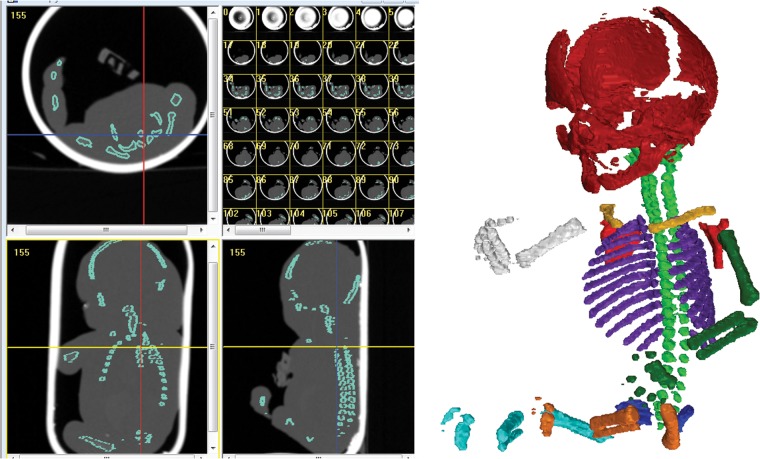
Segmentation and polygon mesh model of fetal skeleton.